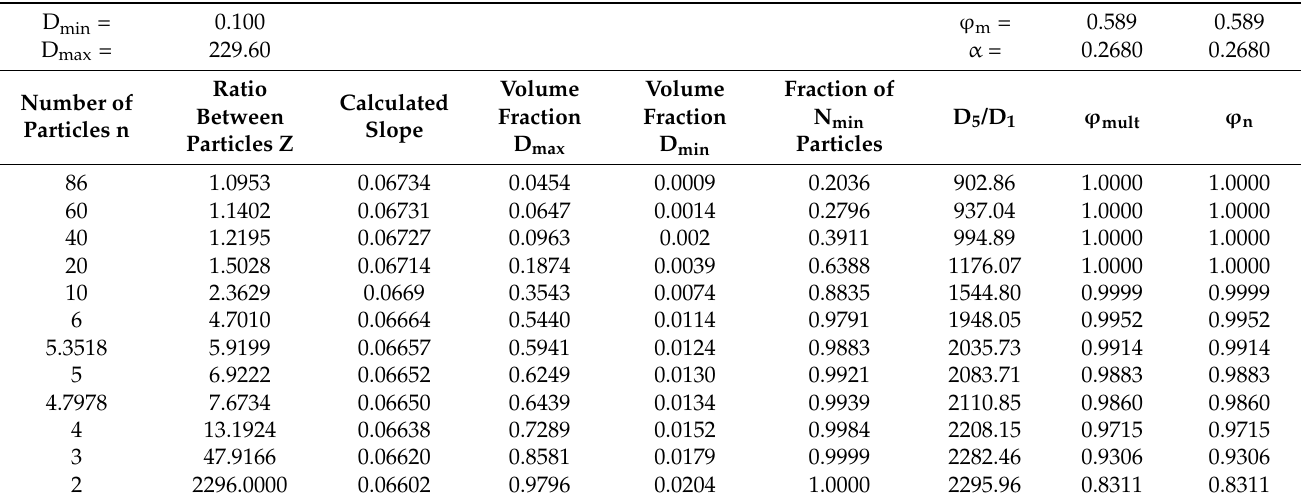
Table 8. Constant slope maximum packing fractions as a function of number of particles and the ratio between particles, Z.